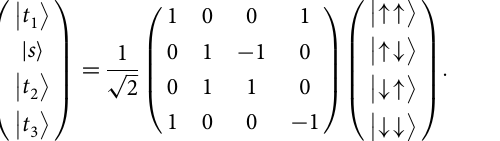
). Here we used > Δ ð p Þ st 1 1